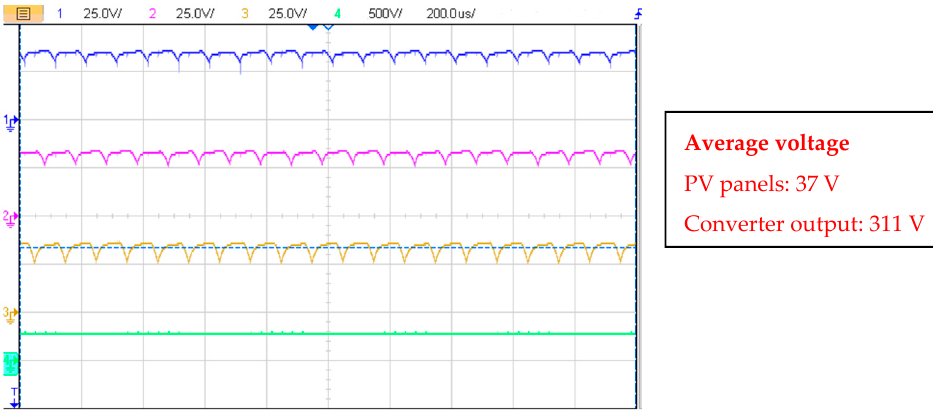
Figure 18. Experimental waveforms. Input voltages: PV panel 1 (blue), PV panel 2 (pink), and PV panel 3 (yellow); scale: 25 V/div. Converter output voltage (green); scale: 500 V/div. Base time: 200 µs/div.